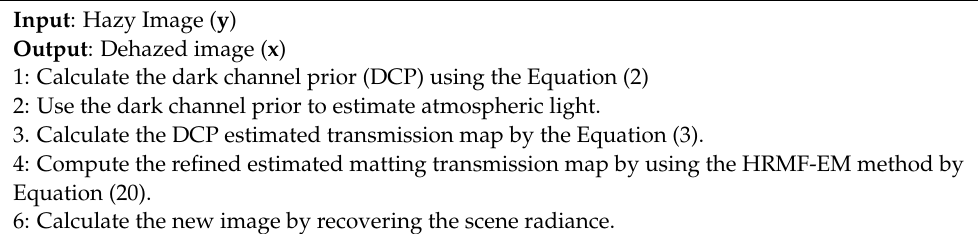
Algorithm 1: Procedure for estimating a refined transmission map with HMRF-EM method and dehazed image by recovering the scene